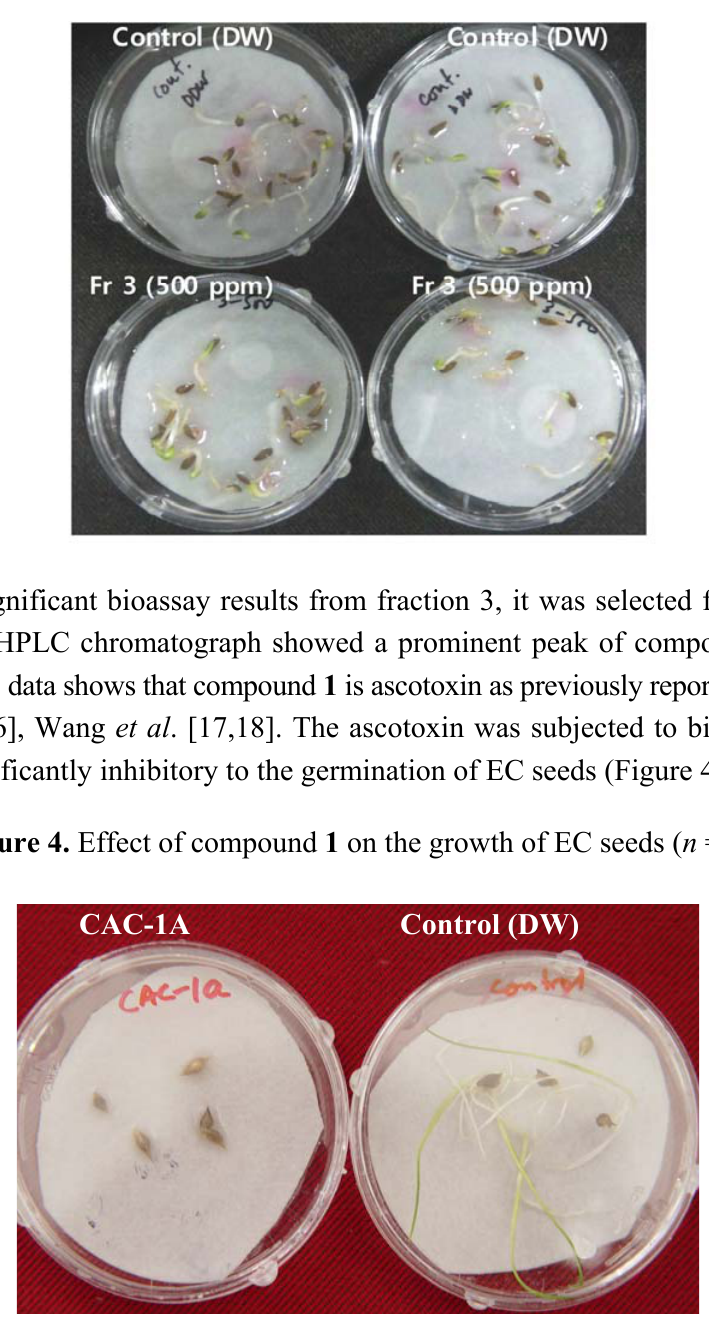
Figure 3. Effect of fraction 3 (500 ppm concentration) on the seed germination of LS ( n = 5).